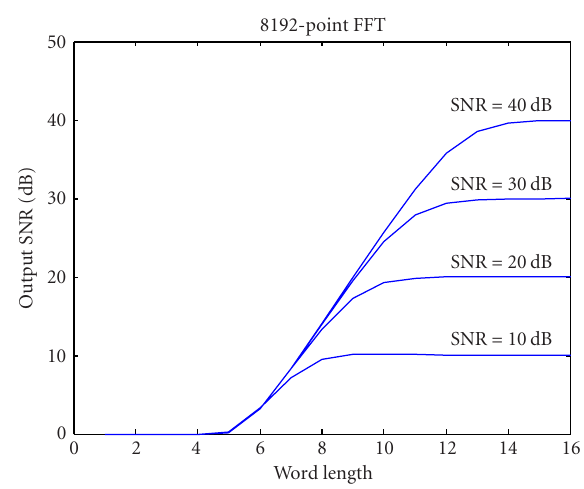
Figure 11: Fixed-point simulation of data word